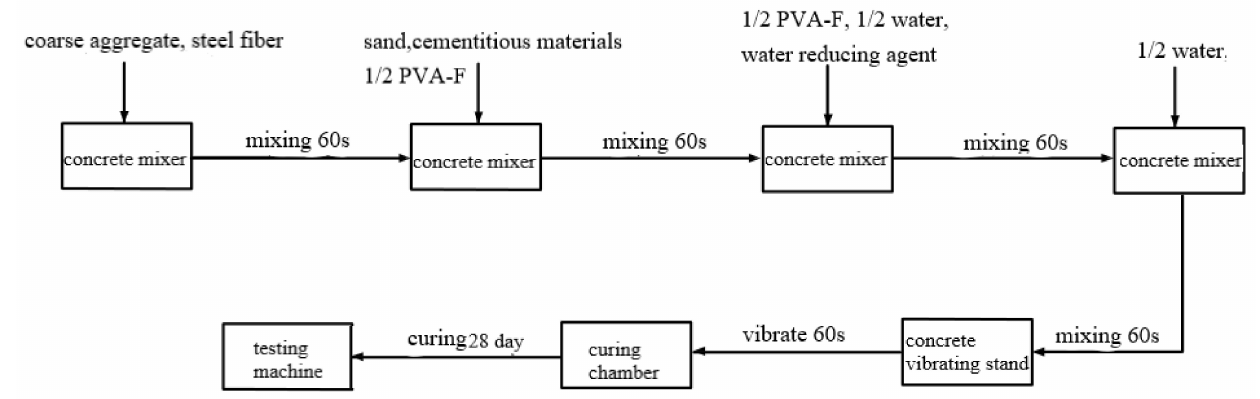
Figure 3. Preparation process of specimens.